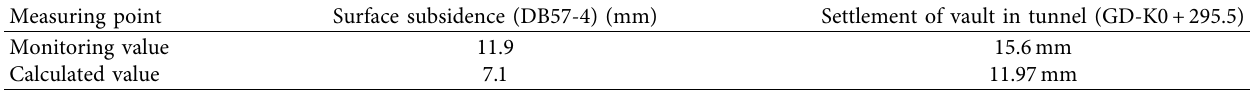
Table 2: Comparison of field monitoring and simulation